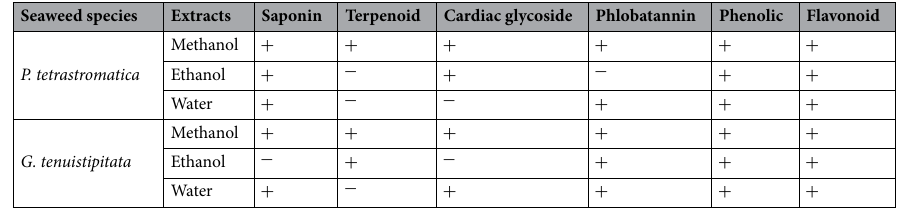
Table 1. Preliminary phytochemical screening of different extracts of P. tetrastromatica and G. tenuistipitata . “+” constituent’s existence, “−” constituent’s